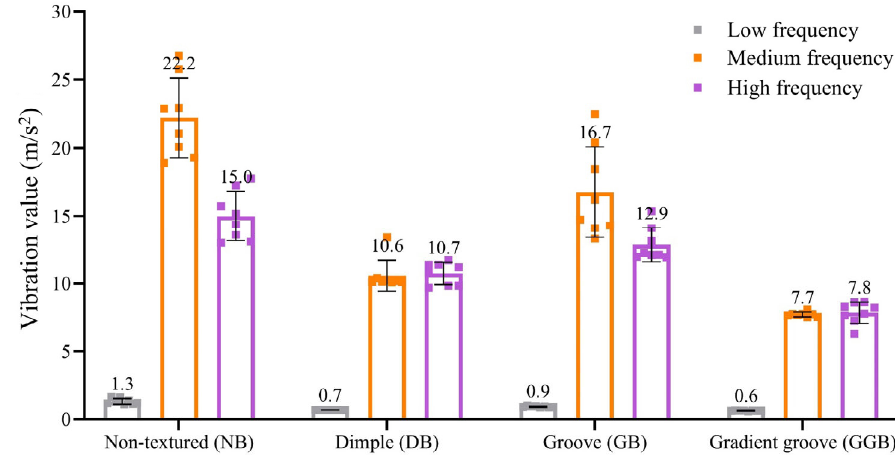
Fig. 12 RMS value of bearing vibration in different frequency